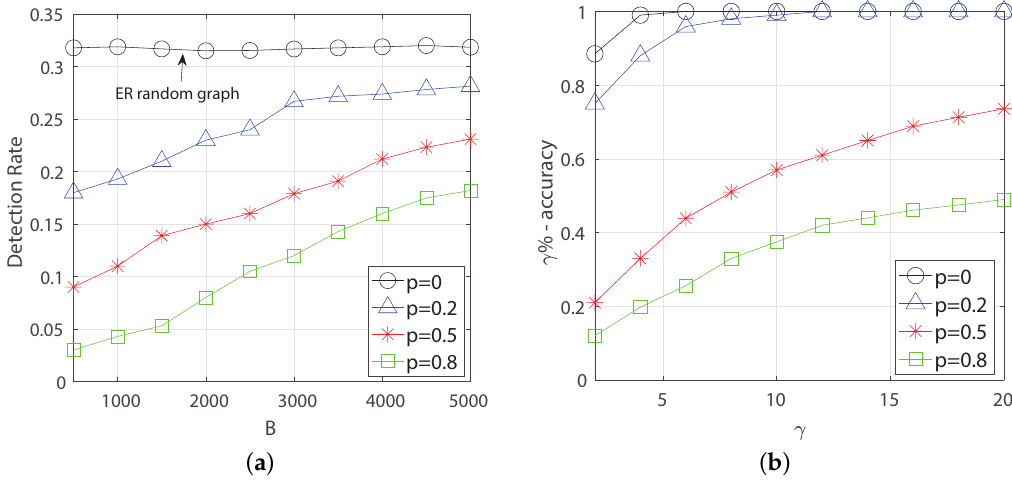
Figure 4. Detection rate and γ %-accuracy of DNSE( k ) for various flipping parameter p . (we set the dynamic parameter k = 5000 and diffusion parameter q = 0.4, respectively.) ( a ) Detection rate vs. Budget B . ( b ) γ %-accuracy. Table 3. Detection probability of DNSE( k ) compared to other methods by varying p . We use the dynamic parameter k = 5000, diffusion parameter q = 0.4, and investigation budget B = 2500. p DNSE JC